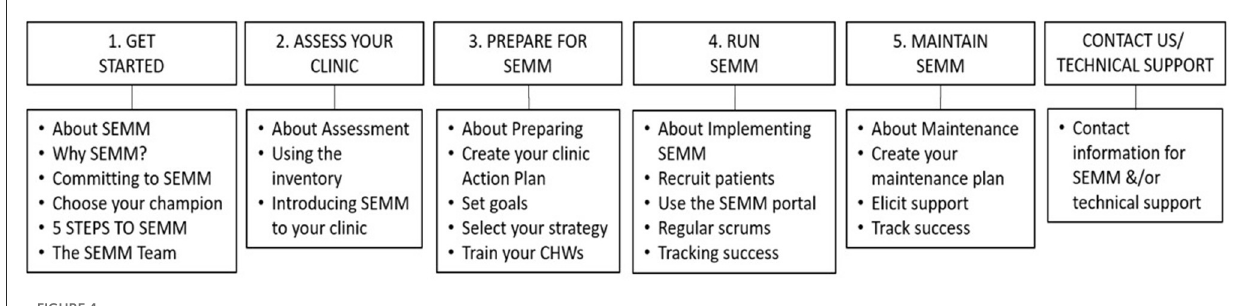
FIGURE4 SEMM-DIA website